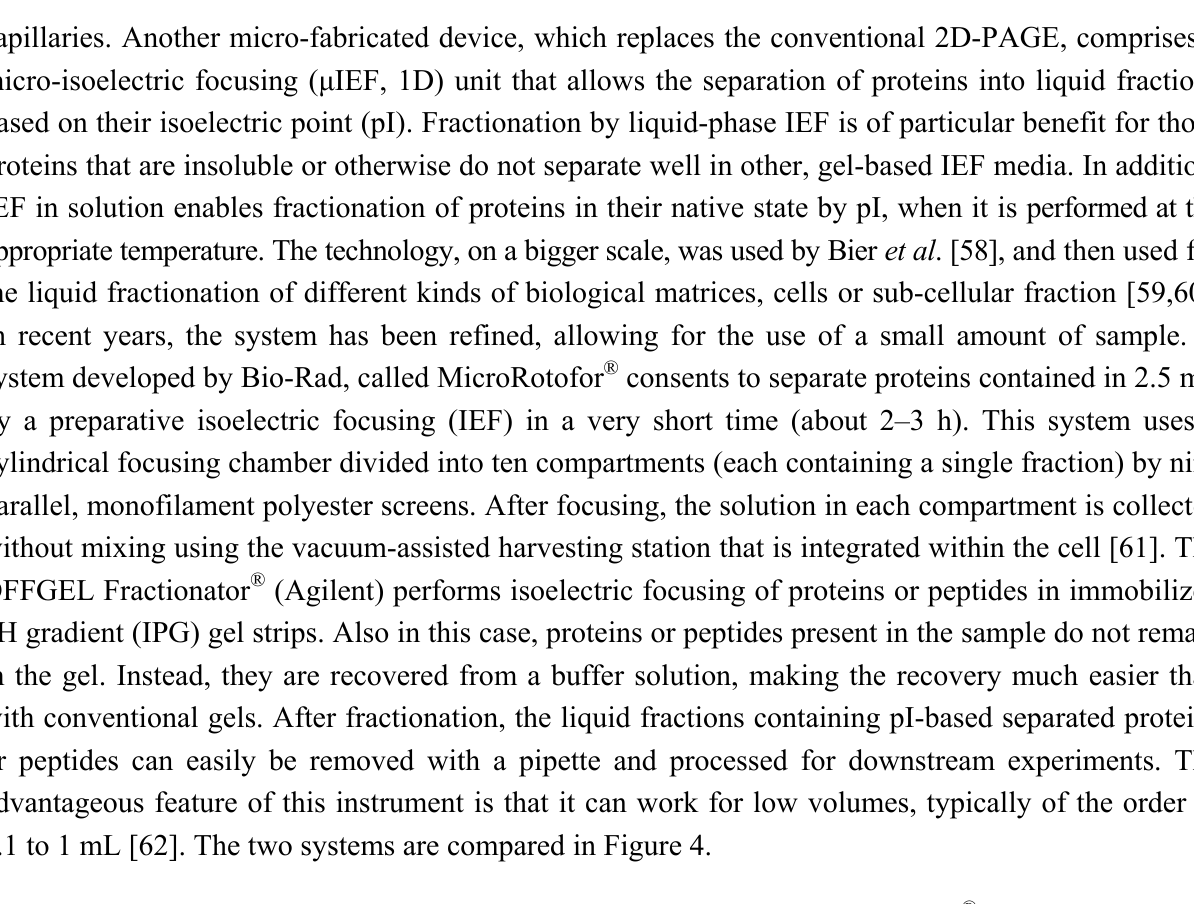
Figure 4. Comparison of the two systems of microelectrophoresis OffGel ® (Agilent) and Microrotofor ®